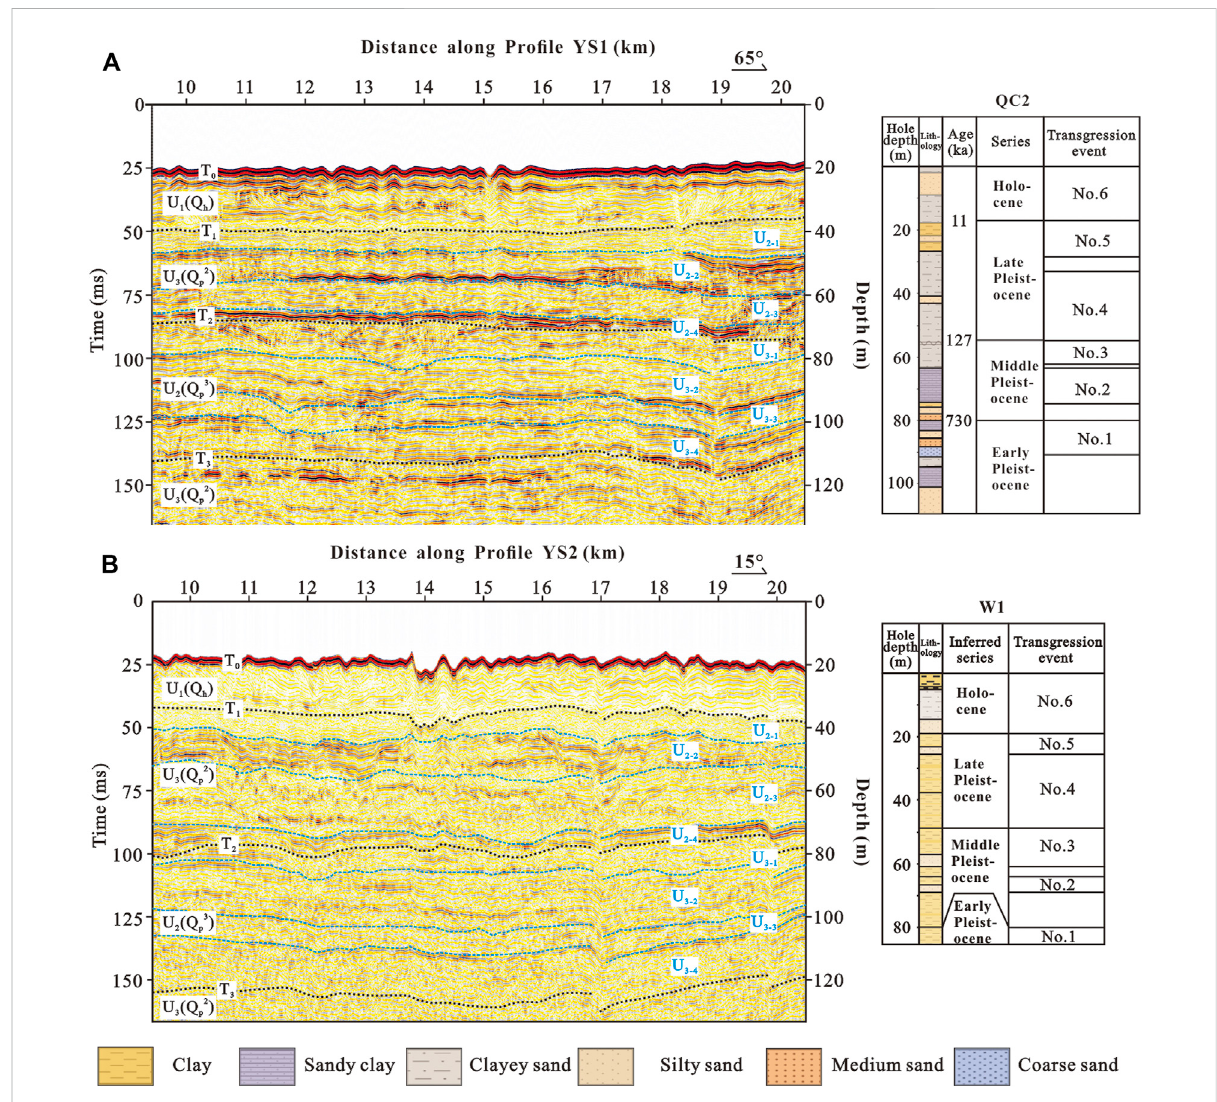
FIGURE 3 Comparison betweenseismicunitsandstratigraphicunits. (A) comparisonbetweenYS1andQC2; (B) comparisonbetweenYS2andW1.T 0 – T 3 : seismic re fl ection interfaces; U 1 – U 3 , U 2 – 1 – U 3 – 4 : seismic